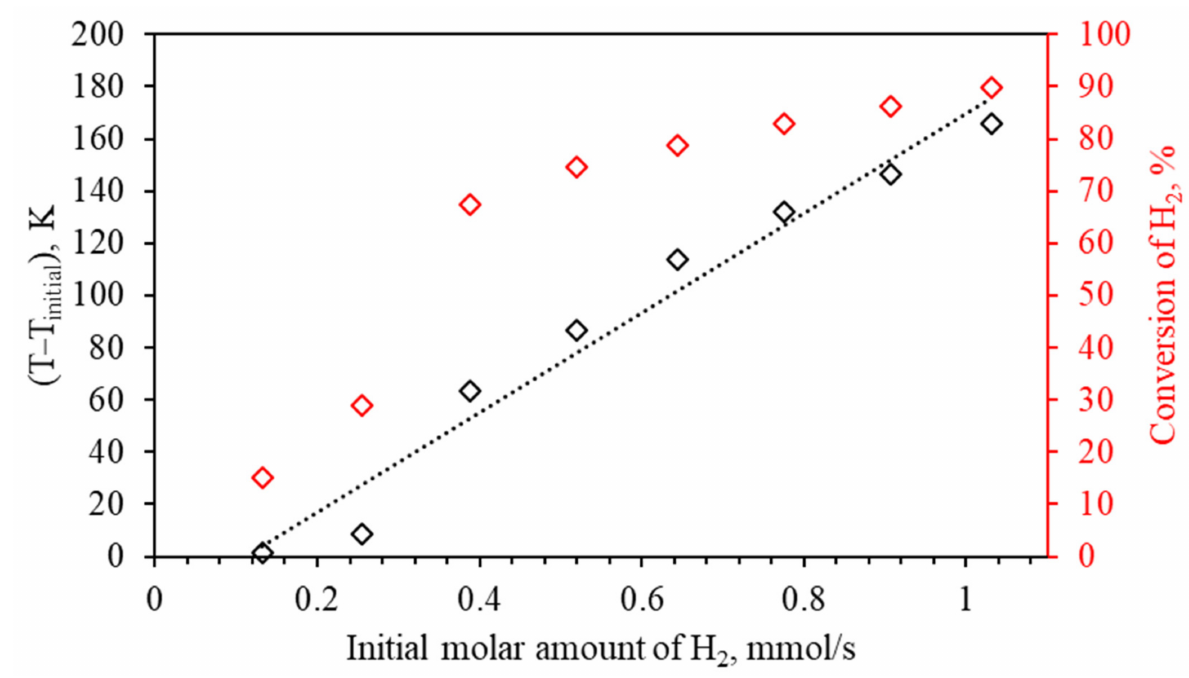
Figure 3. Catalyst surface temperature differences between initial temperature and temperature at steady-state conditions (T–T initial , primary y-axis) and conversion of H 2 (secondary y-axis) as a function of the initial molar amount of H 2 in